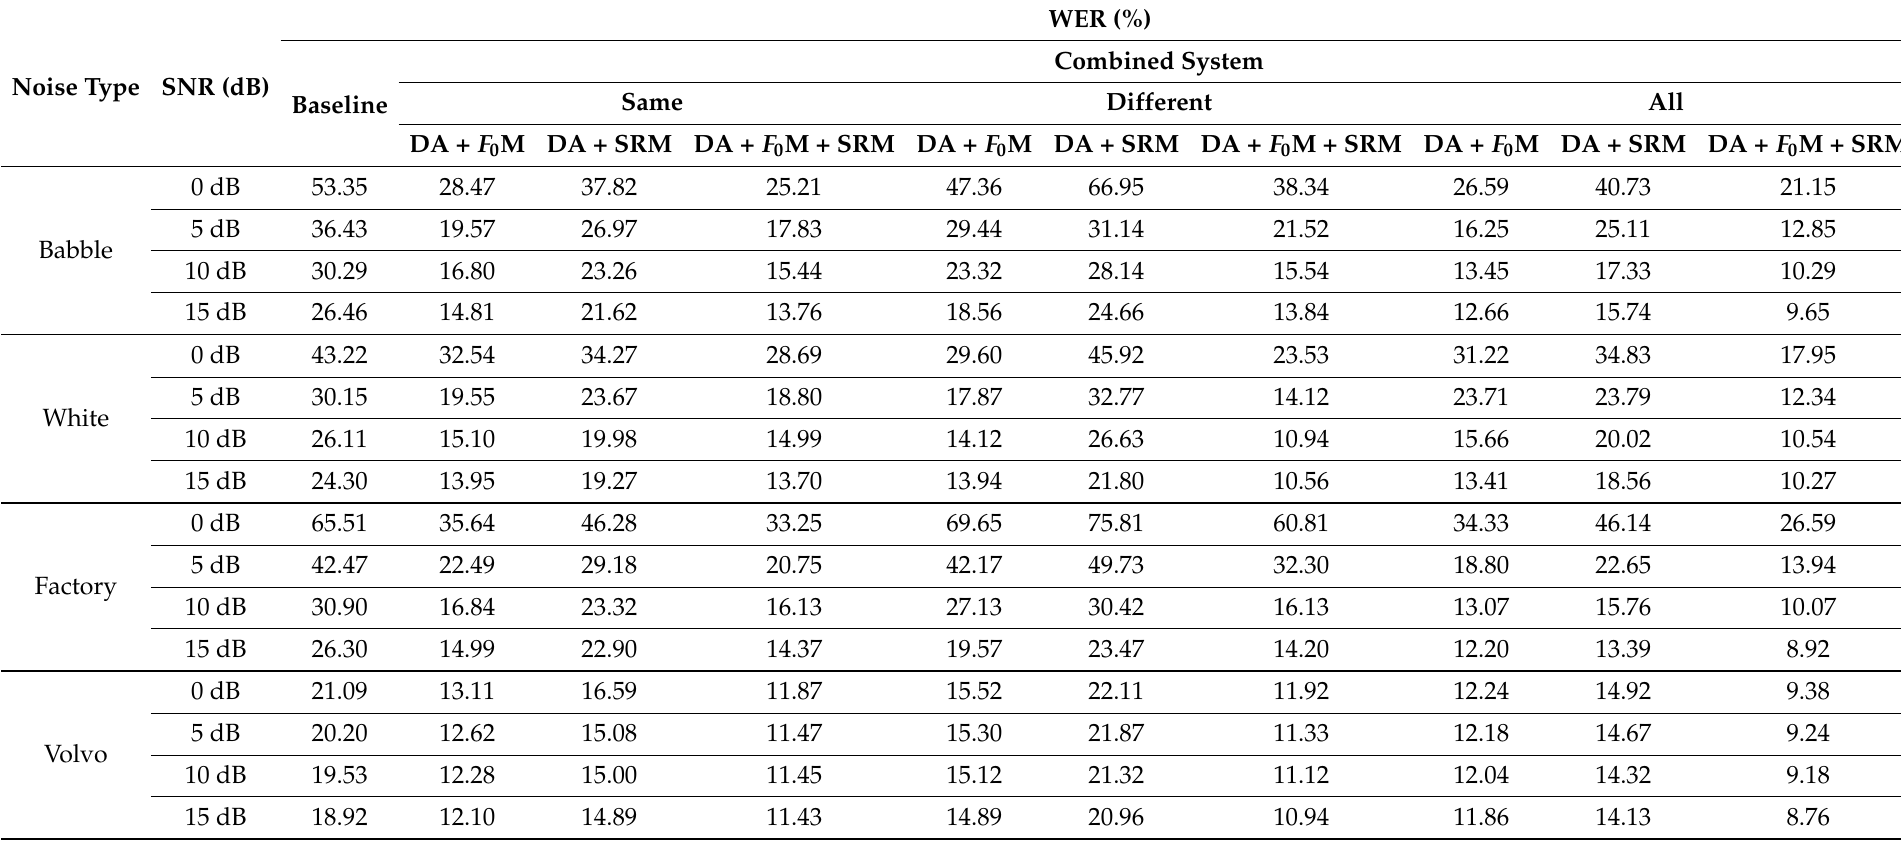
Table 6. WERs obtained in recognizing noisy children’s speech of four noise types in four SNR categories using different combinations of data augmentation (DA), F 0 modification ( F 0 M), and speaking rate modification (SRM). The baseline system is the same as in Table 3. WERs are reported separately for each of the three data augmentation scenarios described in Section